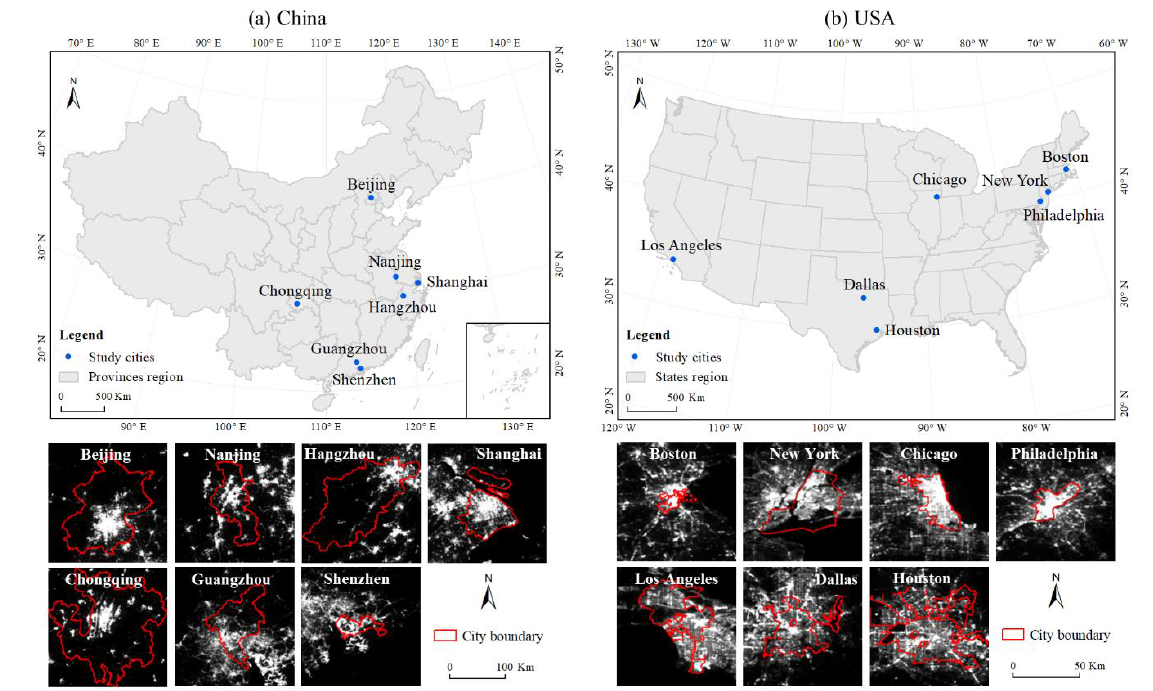
Figure 1. Location and NPP-VIIRS nighttime light images of all study cities. (a) The seven selected cities in China; (b) The seven selected cities in the United States. Table 1. All NTL datasets used in the